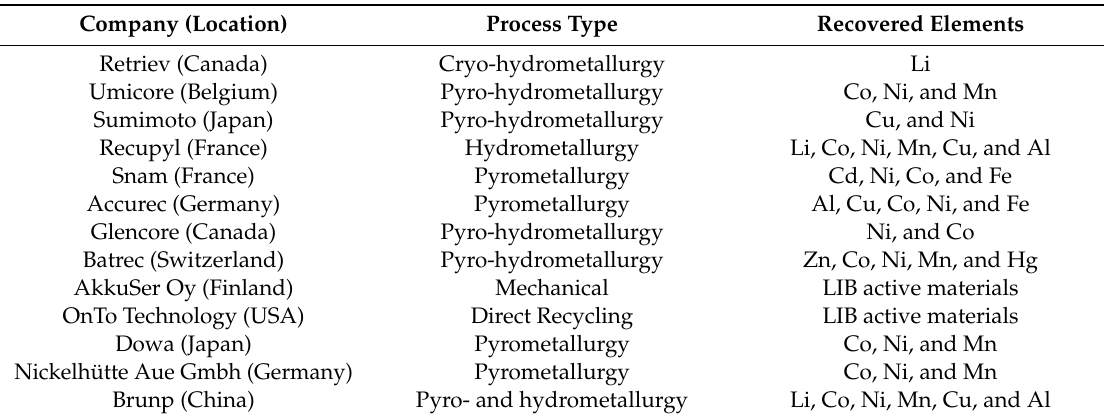
Table 3. List of current recycling facilities and recycling processes they